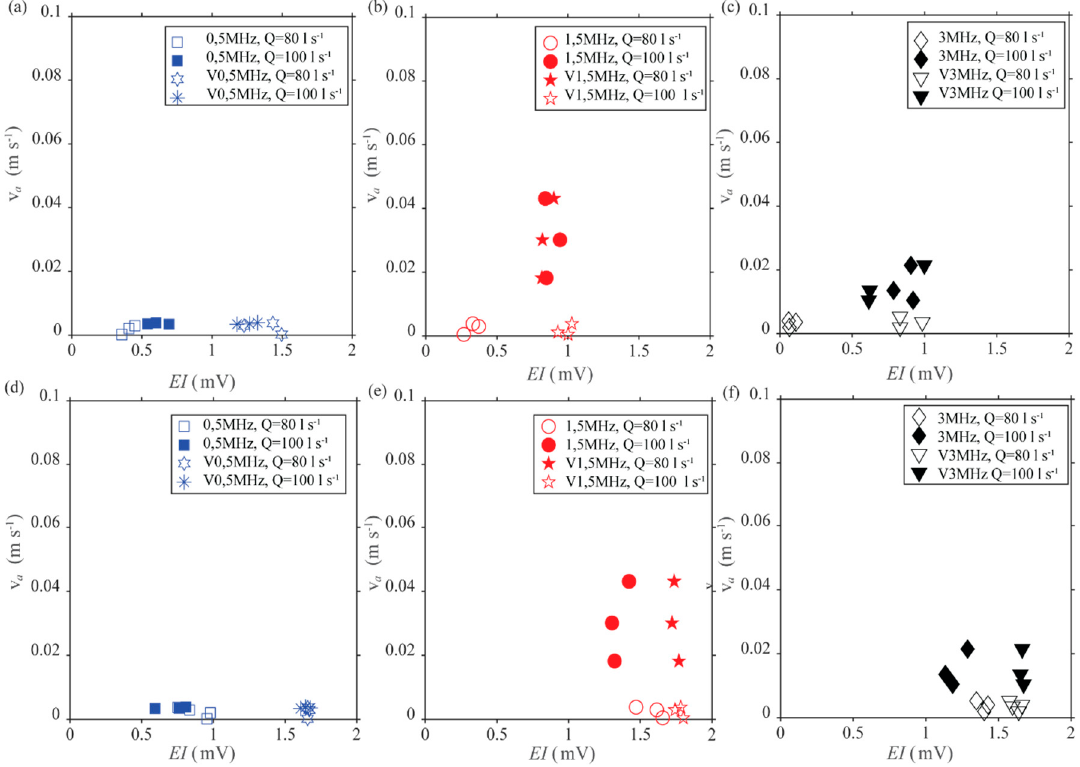
Figure 10. The echo intensity and the apparent bedload velocity measured by the UVPs at NTNU experiment. The V su ffi x indicates vertically aligned UVPs ( ϑ = 90 ◦ ,) whereas ϑ is 25 ◦ and not di ff erently specified. For vertically aligned UVPs, no apparent velocity is available; therefore, it stays the same as measured by the 25 ◦ tilted UVP. ( a – c ) The 0.5–1.5–3.0 MHz UVPs with three averaged cells representing the active layer of bedload moving particles, which were used to estimate the apparent bedload velocity; ( d – f ) 0.5–1.5–3.0 MHz UVPs with two averaged cells above the MAX Amp value representing the loose bottom mostly formed by immobile particles beneath the active layer, which is consistent with the SPro algorithm for riverbed